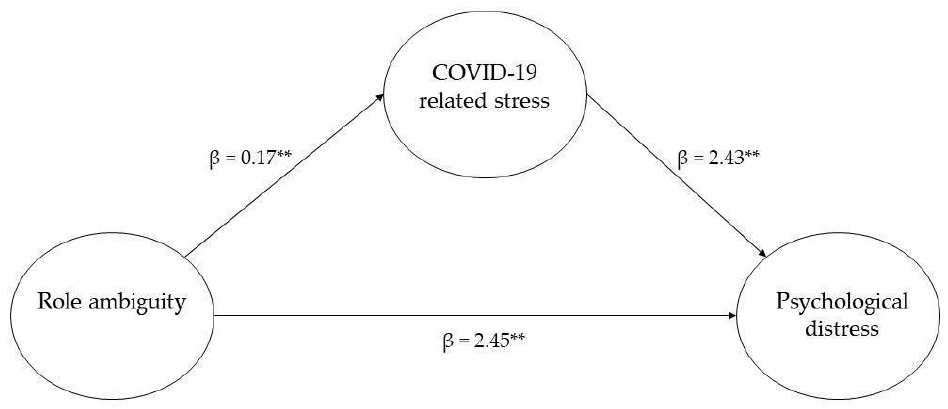
Figure 5. COVID-19-related post-traumatic stress as a mediator between role ambiguity and psychological distress. Note: N = 275, ** p < 0.01.